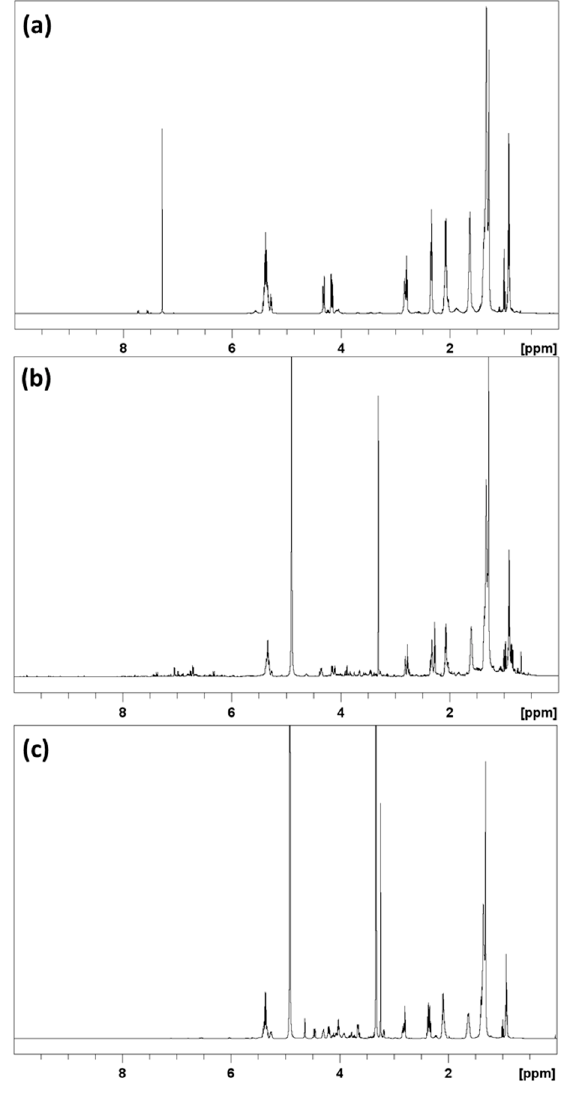
Figure 1. 1 H NMR spectra of hemp seed hull SPE fractions chloroform ( a ) acetone ( b ) and MeOH ( c ). The NMR spectra were measured in CD 3 OD, except for the chloroform fraction, which was measured in CDCl 3 .